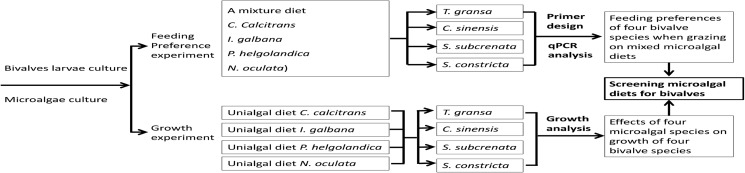
Schematic of experimental design.